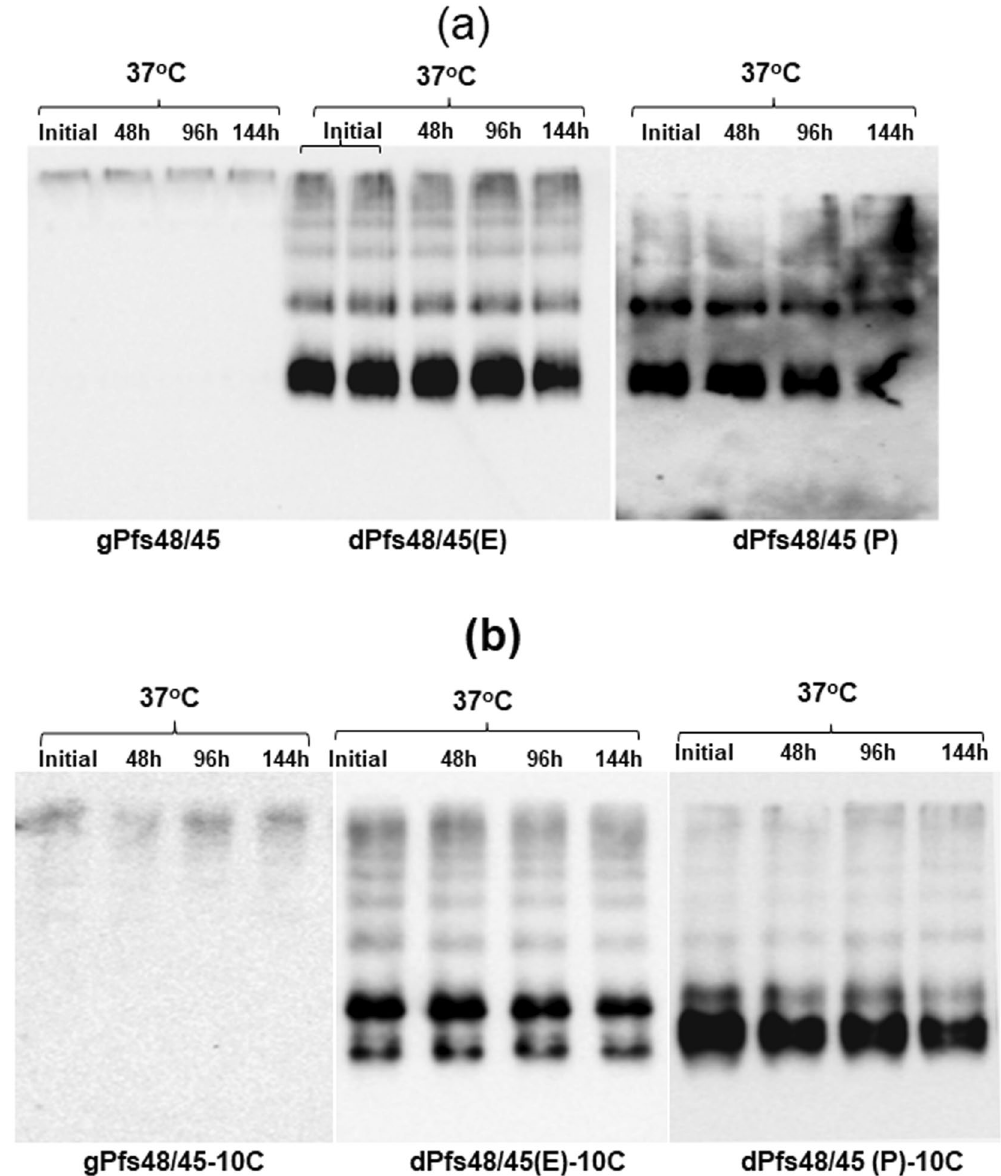
Figure 5. Stability analysis of glycosylated and deglycosylated Pfs48/45 and Pfs48/45-10C variants using conformational specific Pfs48/45 monoclonal antibody. Glycosylated and deglycosylated Pfs48/45 and Pfs48/45- 10C variants were incubated at 37 °C for 48, 96 and 144 hours. Two hundred ng per lane of deglycosylated proteins, as indicated, were run in Native PAGE prior to western blotting. Proteins on the blot were probed with the conformational specific Pfs48/45 monoclonal antibody, IIC5B10-1 (MRA-316). ( a ) Glycosylated and deglycosylated Pfs48/45; ( b ) Glycosylated and deglycosylated